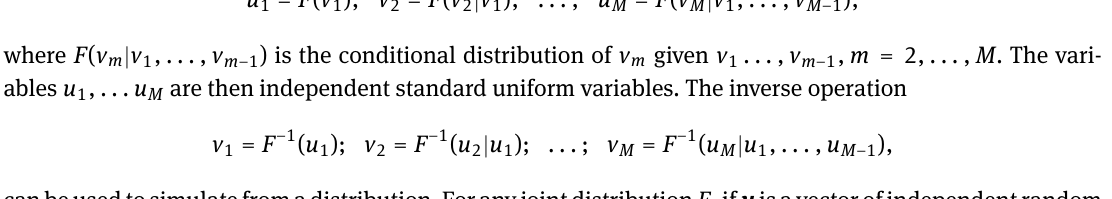
are independent of the conditioning variables x